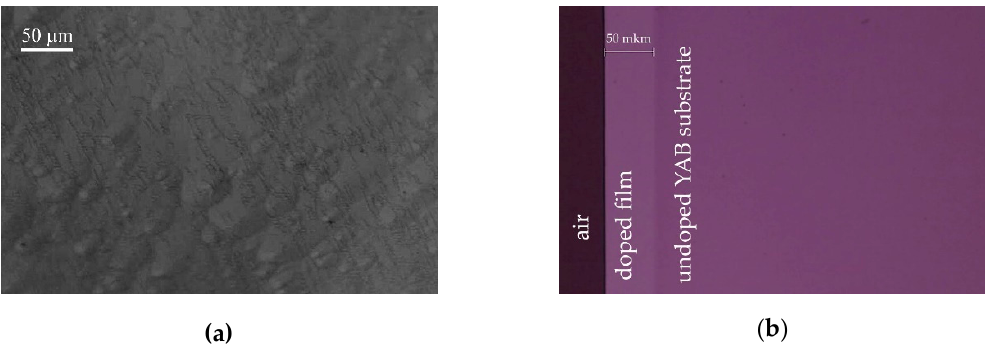
Figure 9. 50 µ m thick as-grown (Er,Yb):YAB layer ( a ) and polarized optical image of the polished cross-section of the (Er,Yb):YAB layer on the YAB substrate ( b ).